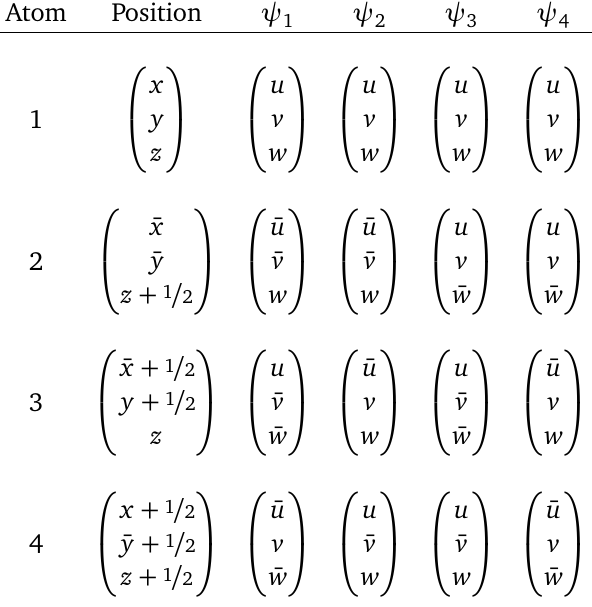
for each of the Fe sites n